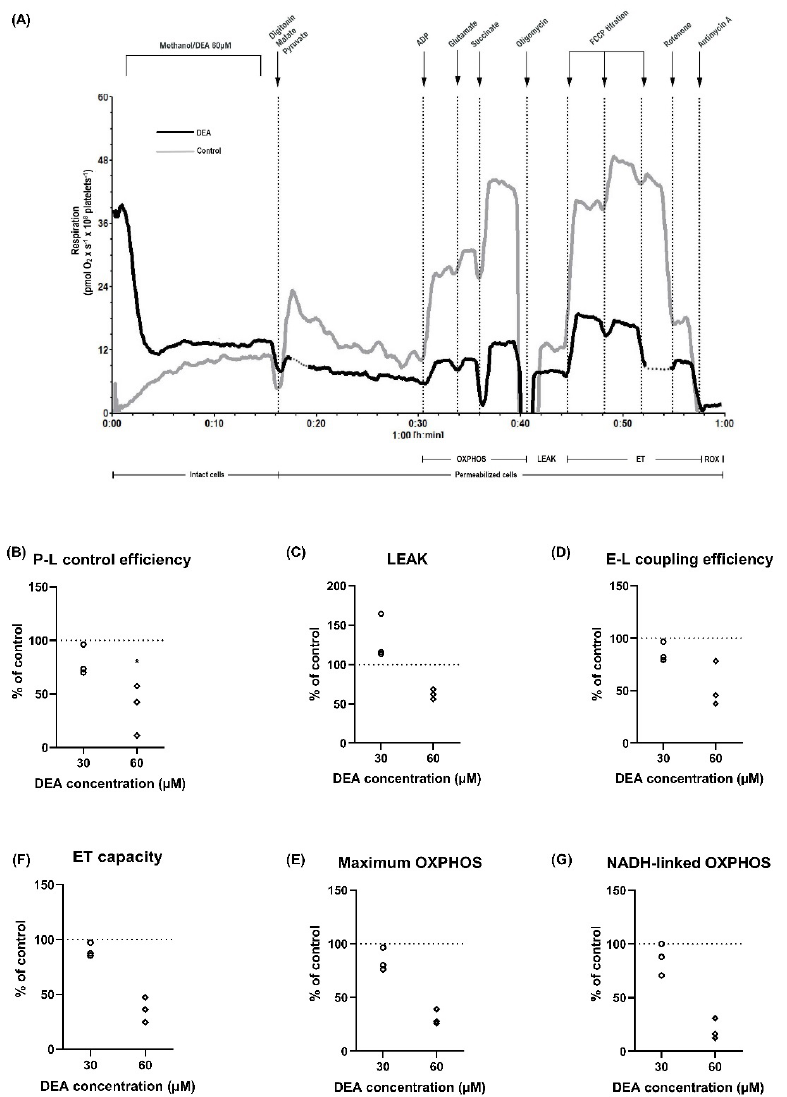
Figure 3. The amiodarone metabolite (DEA) induced a concentration-dependent inhibition of mito- chondrial respiration in permeabilized platelets. ( A ) Representative trace of DEA exposure (DEA- black; methanol-grey). Concentration-effects for two concentrations of DEA (30 µ M-circle and 60 µ M-rhombus). P-L control efficiency, a measure of ATP generating respiration ( B ), LEAK ( C ), E-L coupling efficiency, a measure of ATP generating respiration ( D ), ET capacity ( E ), maximum OXPHOS ( F ), NADH-linked OXPHOS ( G ) were evaluated. Data were expressed as individual values of the percent of control (platelets exposed to the corresponding volume of methanol). Two-way ANOVA with Bonferroni post hoc test was performed on the antimycin-corrected data. DMSO: dimethyl sulfoxide. ADP: adenosine diphosphate. FCCP: carbonyl cyanide p-(trifluoromethoxy) phenylhydrazone. OXPHOS: oxidative phosphorylation. LEAK: non-phosphorylating respiration. ET: electron transfer. ROX: residual oxygen consumption. * p < 0.05 vs. control. n =